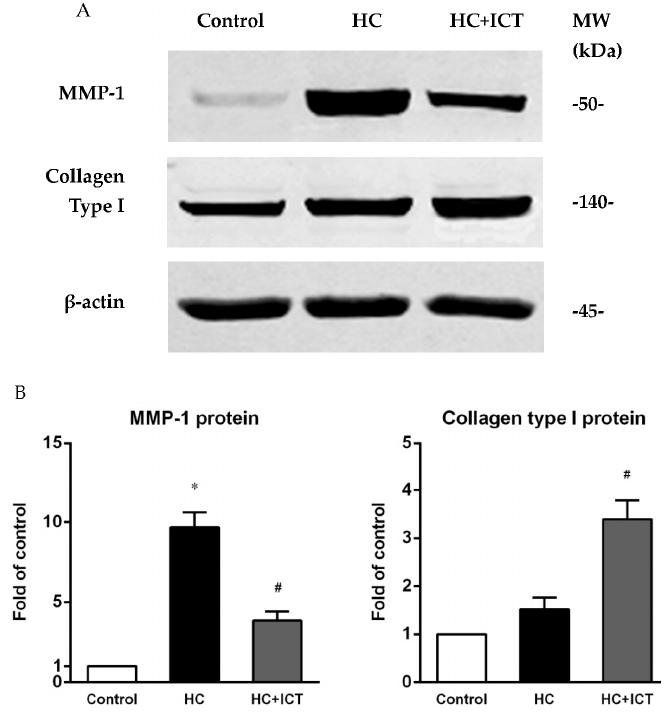
Figure 6. ICT suppressed MMP-1 and up-regulated collagen type I protein contents in aorta homogenates. ( A ) Representative bands of western blot for MMP-1 and collagen type I. β -actin as internal control. MW: molecular weight; ( B ) Expression of MMP-1 and collagen type I protein was normalized to β -actin intensity and presented as the fold of the control group. * p < 0.05, between control and HC groups; # p < 0.05, between HC and HC+ICT groups. n = 9. Data were means ± SEM.